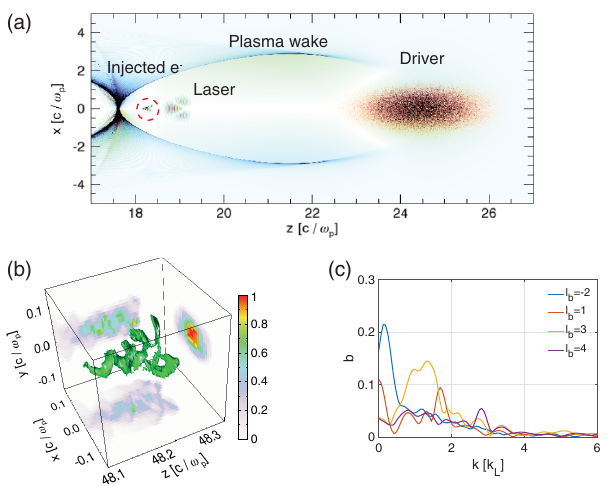
FIG. 3. The structure of the injected electrons when two right- handed CP laser pulses with ð l ¼ 0 ; p ¼ 0 Þ and ð l ¼ 2 ; p ¼ 0 Þ are used. (a) A illustration of the laser-triggered ionization injection in a beam driven plasma wake. (b) Density isosurface and its projections to each plane. (c) The bunching factor. The profiles of the pulses are as same as in Fig.